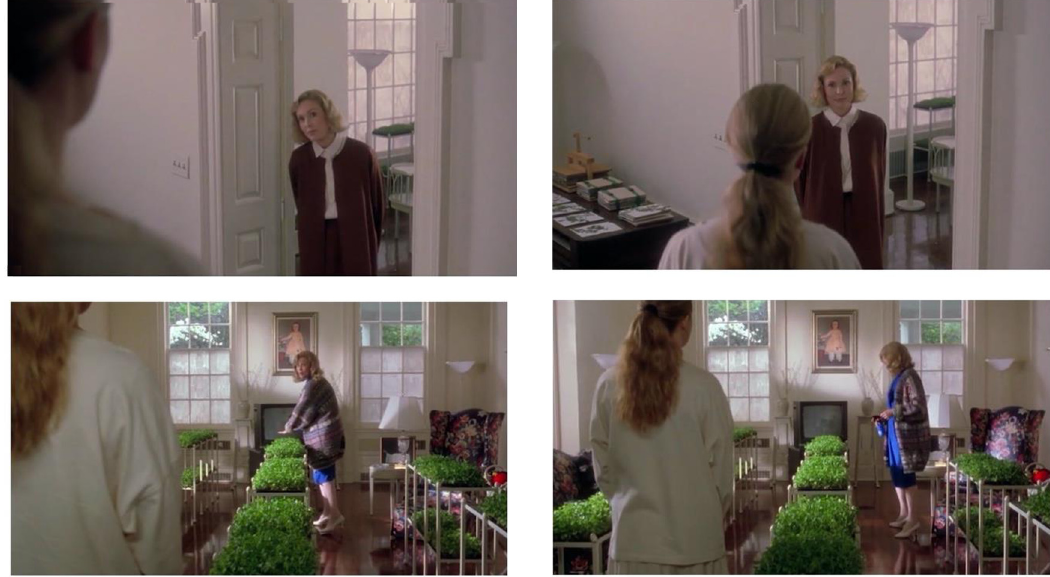
Figure 2: Aunt Lydia ( Victoria Tennant ) introduces O ff red/Kate ( Natasha Richardson ) to Serena Joy ( Faye Dunnaway ) in Schlöndor ff ’ s The Handmaid ’ s Tale